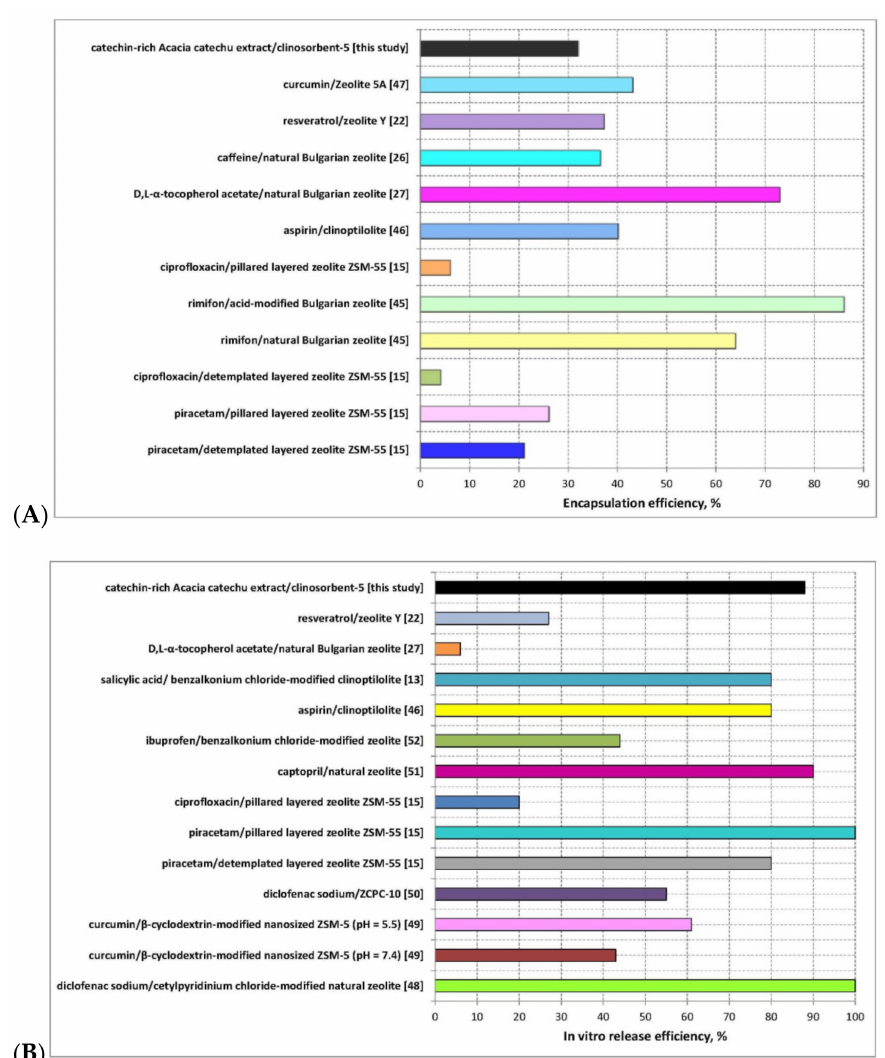
Figure 6. Literature review on the ( A ) encapsulation and ( B ) in vitro release efficiency of syn- thetic/natural bioactive substances-zeolite carrier systems